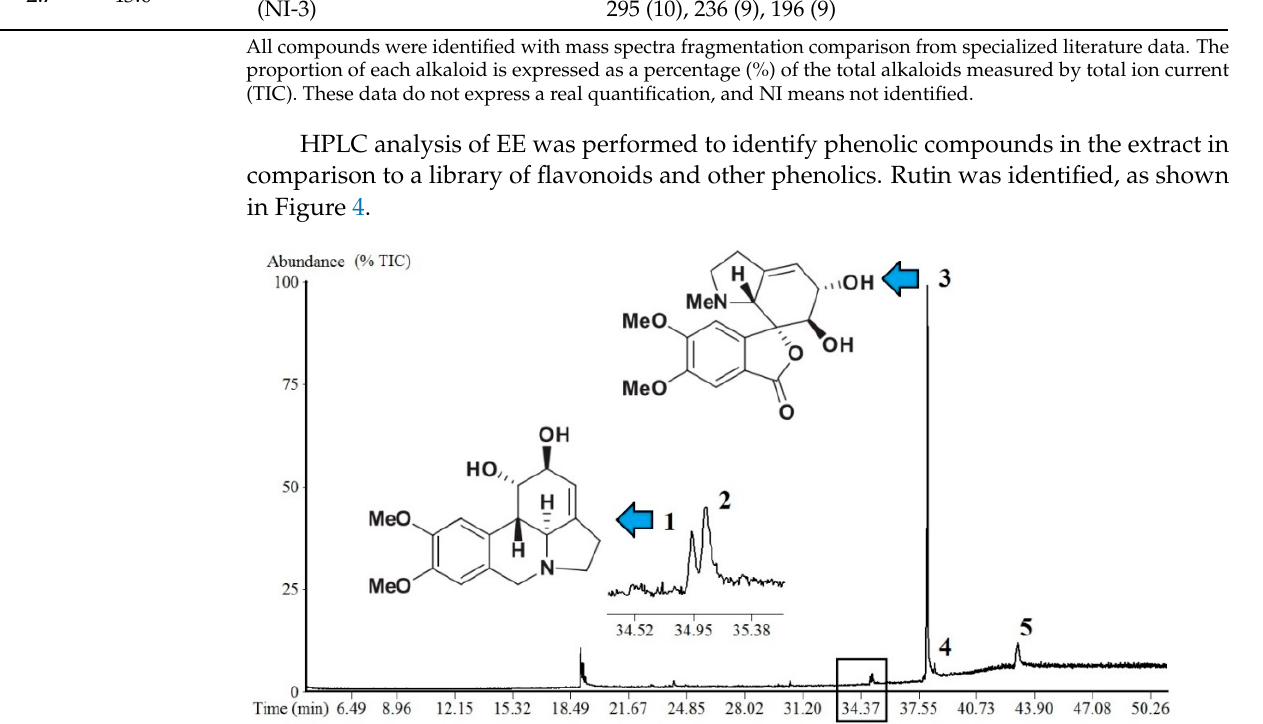
Figure 3. Alkaloids of Hippeastrum stapfianum leaves, identified by gas chromatography–mass spec- trometry (GC-MS). GC-MS chromatogram with relative % of total ion current (TIC). The black box refers to peaks 1 and 2.